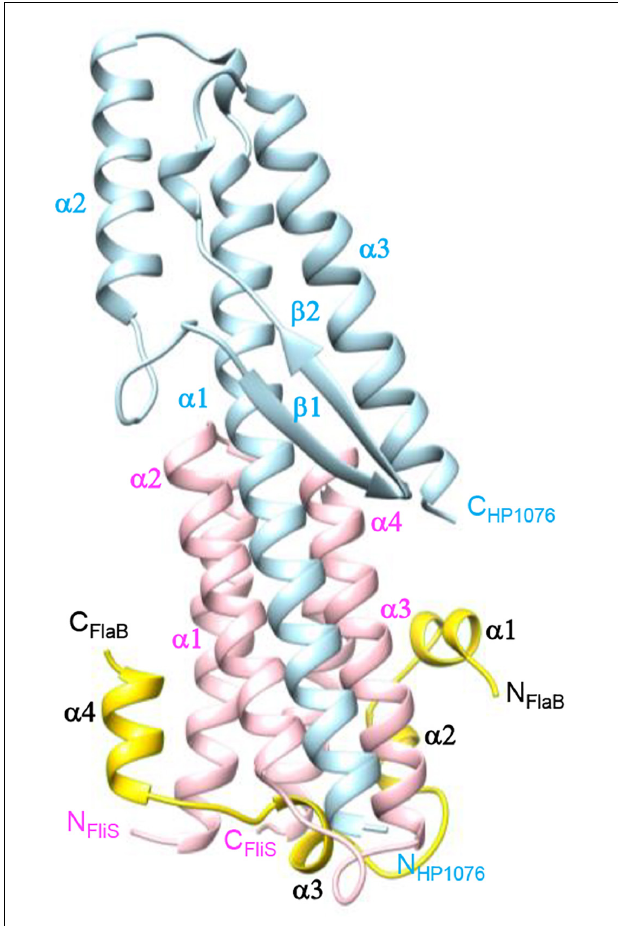
FIGURE 1 | Crystal structure of FliS in complex with FlaB C and HP1076. FlaB C (yellow) binds exclusively to FliS (pink), while HP1076 (blue) interacts with FliS via the packing of helices α 1 of HP1076 and α 2– α 3 of